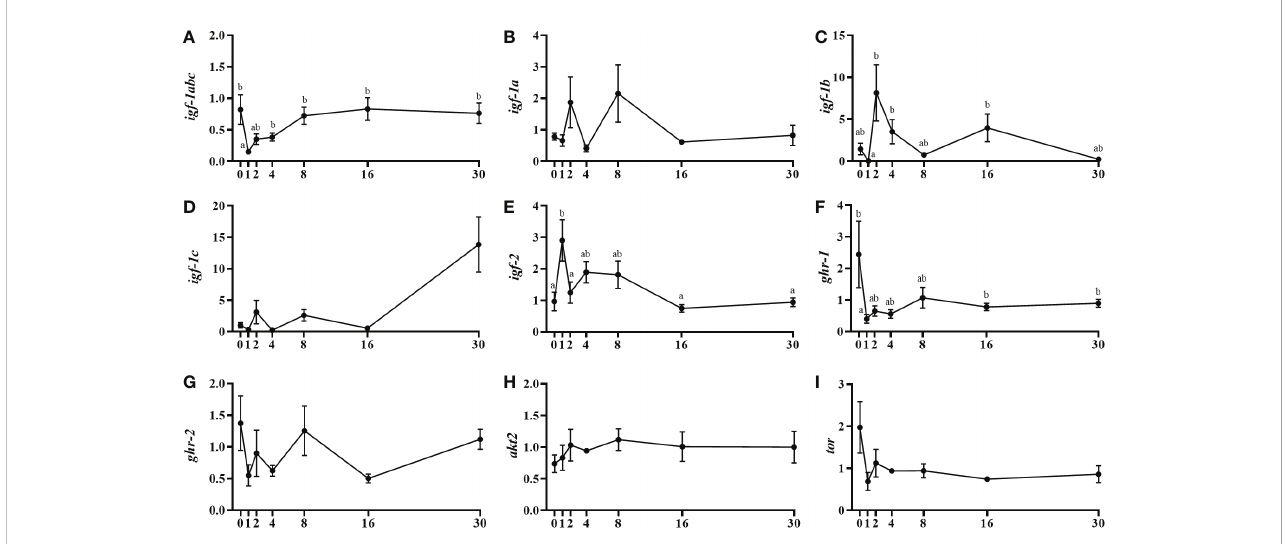
FIGURE 2 Relative gene expression of the insulin-like growth factors, igf-1abc (A) , igf-1a (B) , igf-1b (C) , igf-1c (D) , igf-2 (E) , growth hormone receptors, ghr-1 (F) , ghr-2 (G) , and signaling molecules, akt2 (H) , and tor (I) in injured epaxial muscle of fi sh. Data are shown as means ± SEM, n=10. Statistical analysis was assessed by one-way ANOVA. Different letters indicate signi fi cant differences of factor time (days post-injury) (Tukey ’ s HSD or Games-Howell post-hoc test, p < 0.05).